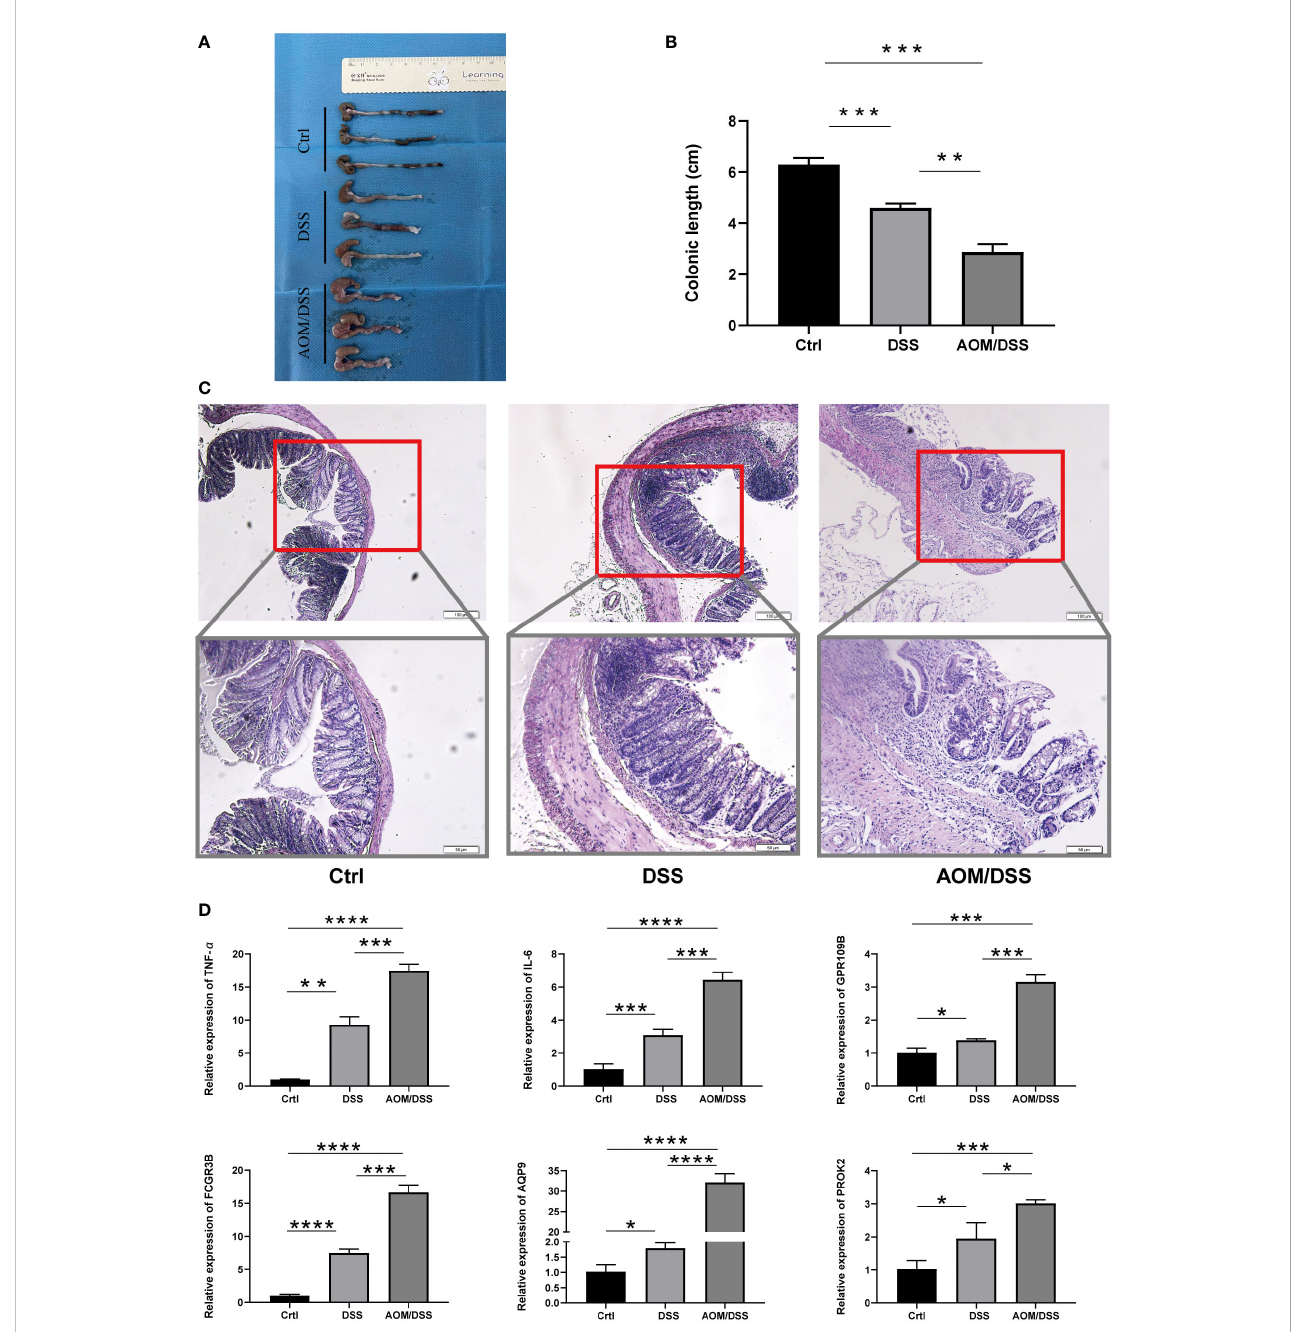
FIGURE 6 Expression of fi ve markers in the mouse model. (A, B) Colon length of different groups of mice. (C) Representative H&E staining of different groups of (D) colon. (C) RT-PCR analysis of differential gene expression results in the Crtl, DSS and AOM/DSS groups. The asterisks represented the statistical p-value (*P < 0.05, **P < 0.01, ***P < 0.001, and ****P <